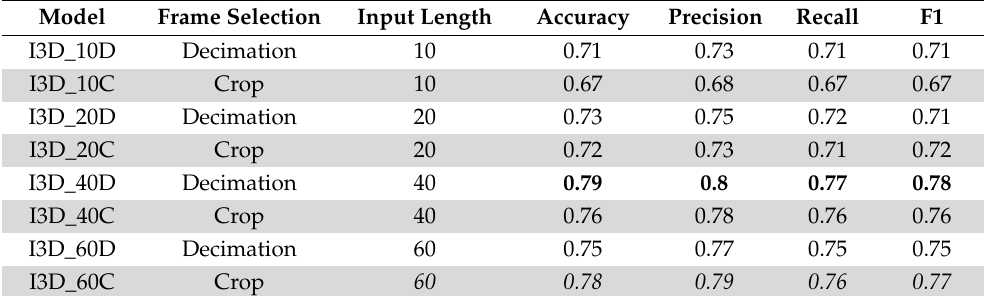
Table 3. Action recognition results for the I3D models on the UNIRI-HBD_v2 dataset with varying input length from 10 to 60 frames and decimation and crop frame selection strategies. The best results are presented in